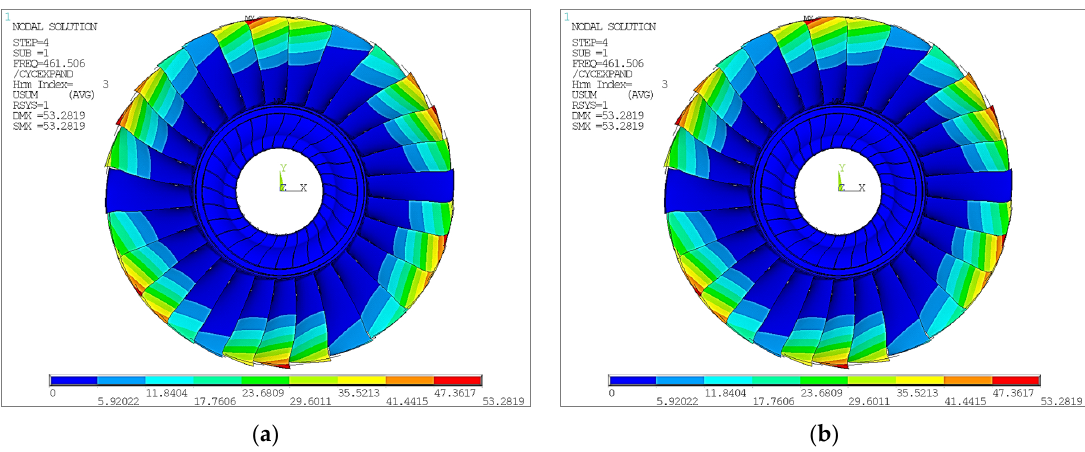
Figure 15. 3 ND first Bend mode for the blisk: ( a ) Displacement vector sum; ( b ) Von Mises stress. Table 1. Modal parameters for the blisk.